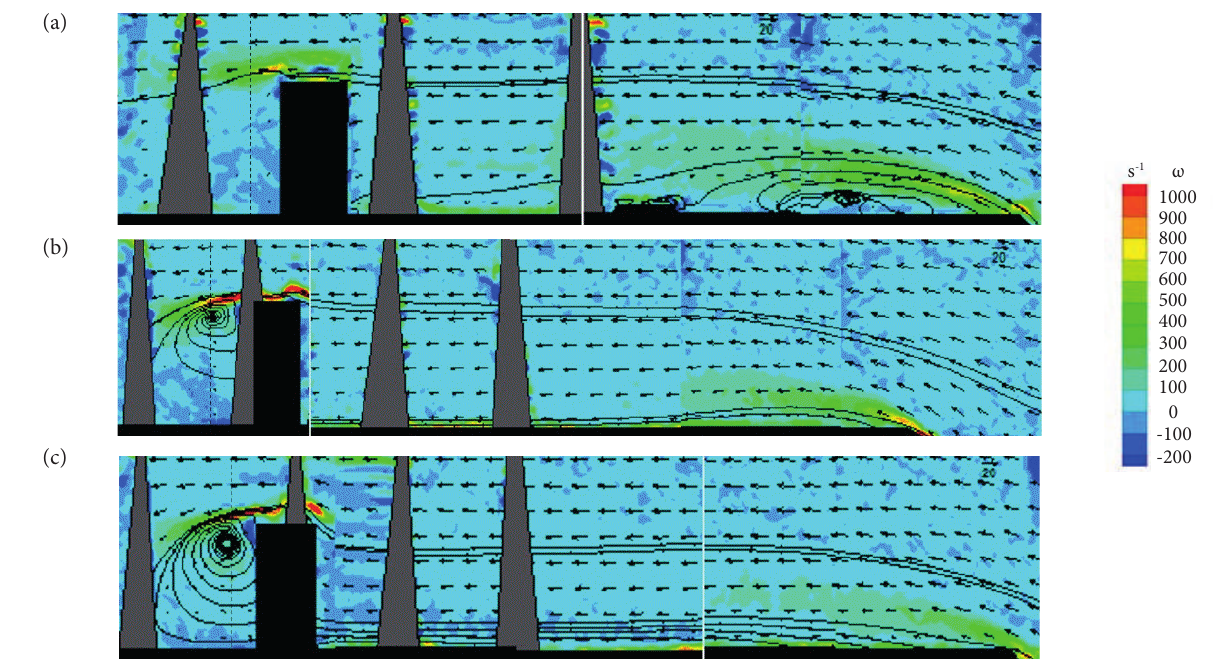
Figure 16. Vorticity contours and velocity vectors – β = 70°, Re = 4.3 × 10 5 . (a) α = 0°; (b) α = 35°; (c) α =